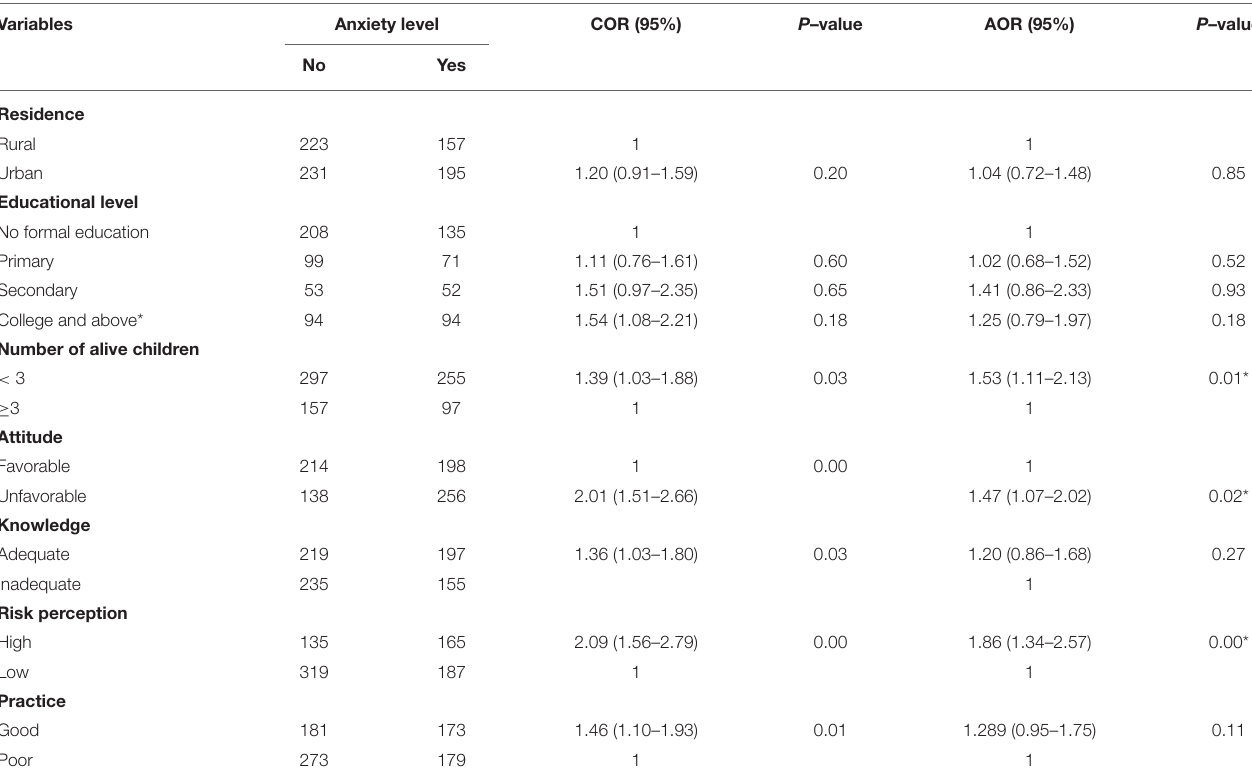
TABLE 3 | Factors associated with generalized anxiety disorder among pregnant women attending ANC during COVID-19 pandemic at public health facilities of East Gojjam zone, Amhara region, Ethiopia, 2020. ( n = 806).